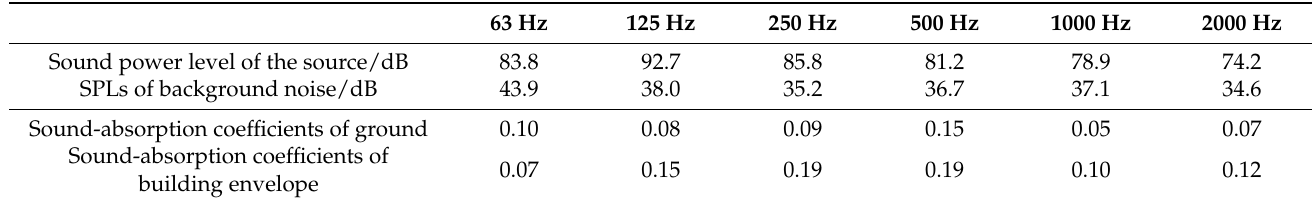
Table 1. Acoustic parameter settings of the virtual model in noise